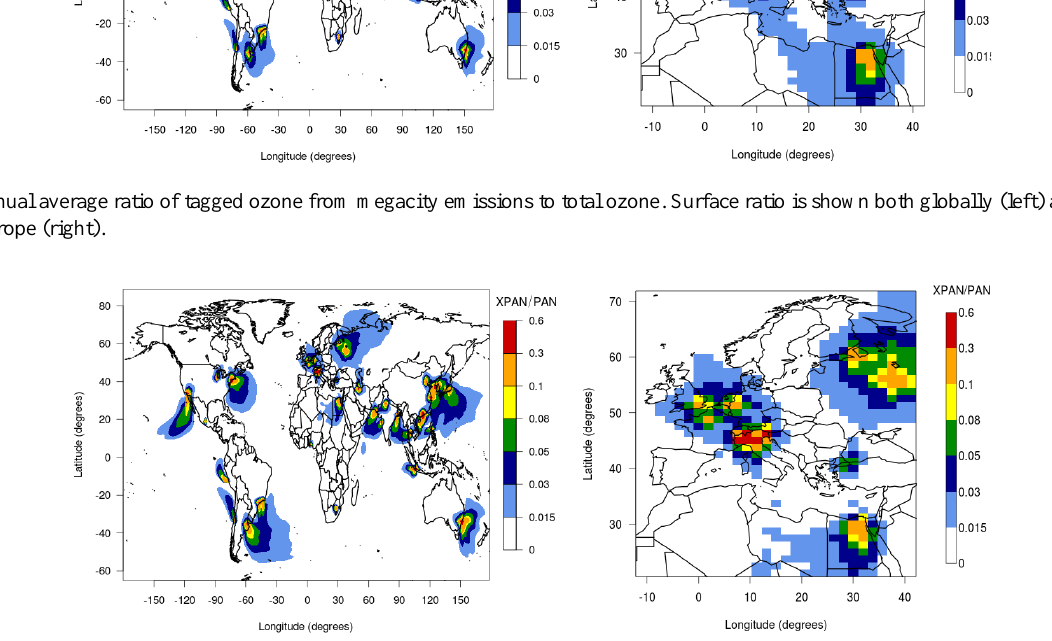
Fig. 7. Annual average ratio of tagged PAN from megacity emissions to total PAN. Surface ratio is shown both globally (left) and zoomed in over Europe (right).